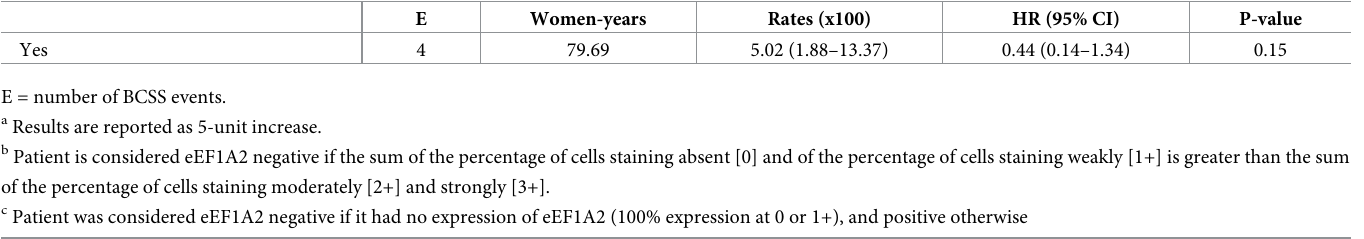
[52]. Moreover, due to the lack of specific cellular receptors in cancer cells, targeted therapies have not been established, and, as a result, TNBC mortality remains high [11,52]. Many studies documented a high rate of recurrence among TNBC patients [53,54]. In our TNBC cohort we found a distant recurrence rate of 36.90%, in agreement with literature data [53]. The risk of